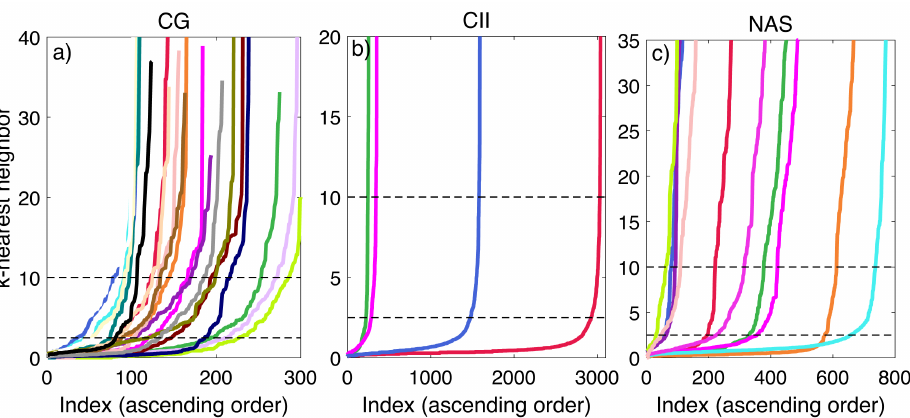
Figure A3. The k-nearest neighbor plot of the potential clusters with N ≥ 100 events in ( a ) CG ( b ) CII and ( c ) NAS. Black horizontal dashed lines indicate the range of (cid:101) values given as input to the DBSCAN algorithm and each color corresponds to a potential cluster.